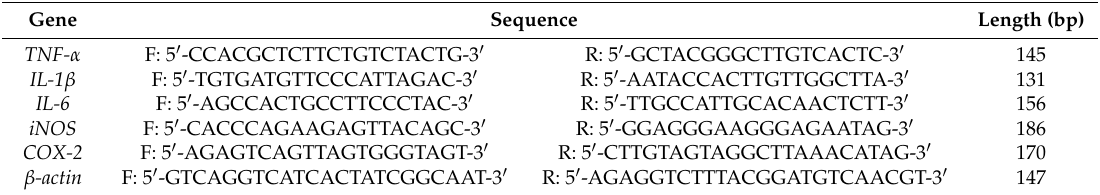
Table 1. The primer sequences of TNF- α , IL-1 β , IL-6, iNOS, COX-2 and β